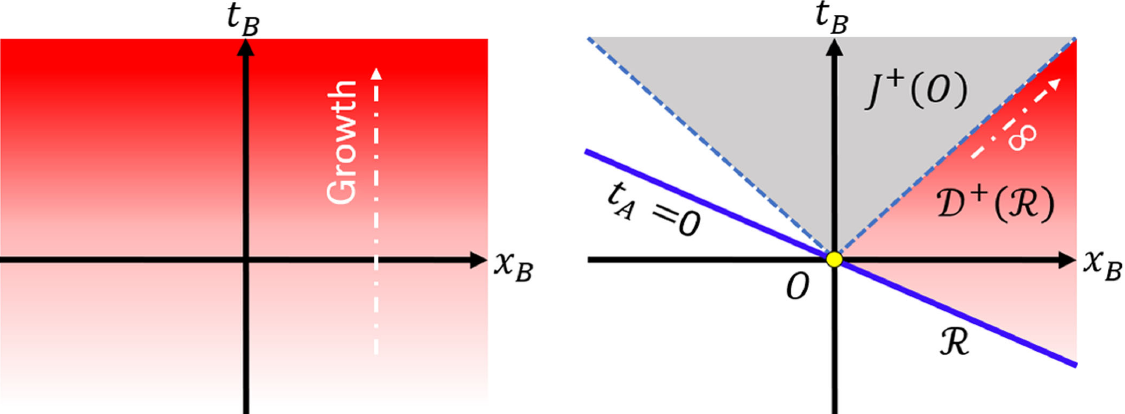
FIG. 5. Minkowski diagram of the two solutions φ (left panel) and φ ⋆ (right panel) in Bob ’ s coordinates. The shades of red are a color map of the perturbation (the oscillatory behavior of the periodic part is averaged out). In the gray area, we do not know the actual intensity of φ ⋆ . Left panel: φ is an unstable Fourier mode (i.e., a growing plane wave) in the B frame; it is well defined across the whole spacetime; its oscillation amplitude is constant along hyperplanes t ( φ ∝ e Γ B t B ). Right panel: φ ⋆ is constructed on the half spacetime f t 0 Þ ¼ φ ð t 0 Þ so that (by causality) φ ⋆ ¼ φ on D þ ð R Þ . On the left, we set φ ⋆ ð t φ ⋆ ð t A ¼ A ¼ Cauchy development). In this way, φ ⋆ has a well-defined Fourier transform on f t corner), signaling an instability in Alice ’ s